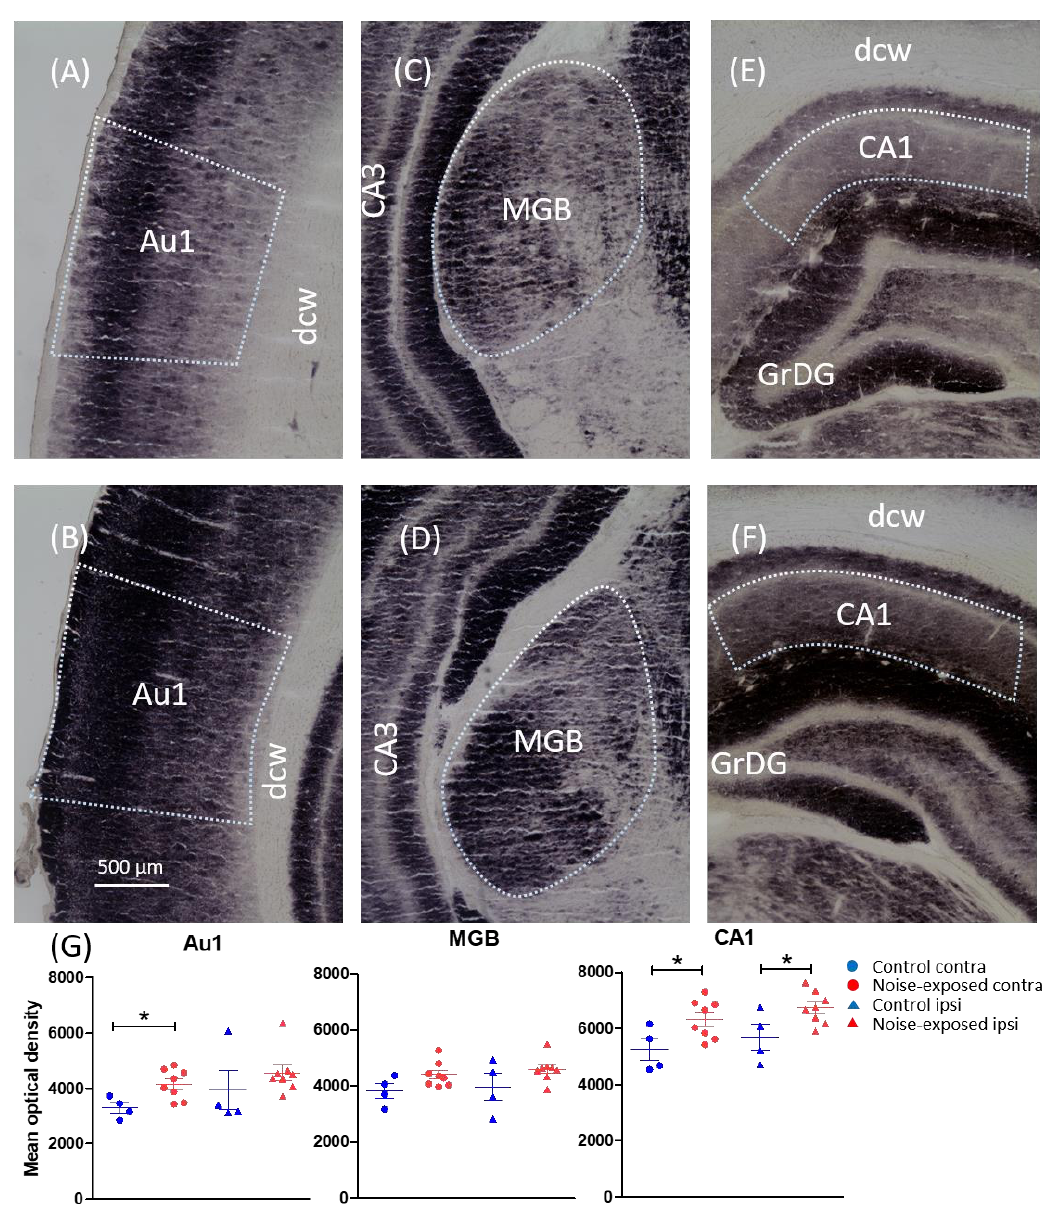
Figure 1. Representative low-power photomicrographs taken from coronal rat brain sections stained with COX. ( A , B ) auditory cortex; ( C , D ) medial geniculate body; ( E , F ) CA1 of the hippocampus. The upper and lower panels represent a noise-exposed and control animal, respectively. ( G ) Graphs show the mean optical density of regions that showed significant changes based on group factors (noise-exposed vs. control). p value < 0.05 was defined as significant level and is indicated by an (*). Note that only contralateral Au1 and bilateral CA1 showed significant changes. Scale bar = 500 µm. Au1, primary auditory cortex; dcw, deep cerebral white matter; GrDG, granular layer of dentate gyrus; MGB, medial geniculate body.